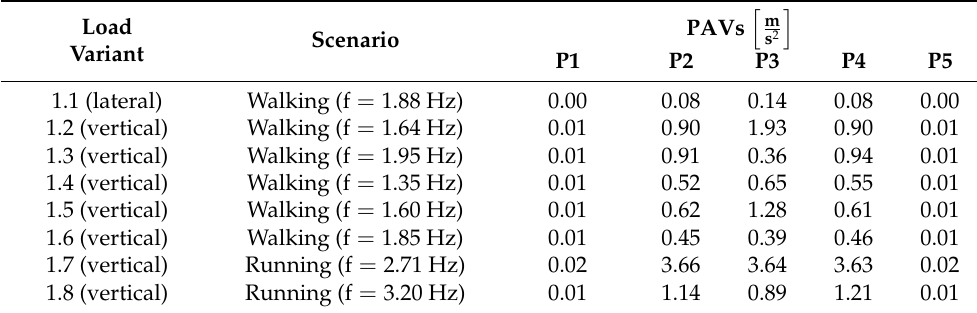
Table 12. The dynamic response of the footbridge for a one-pedestrian passage